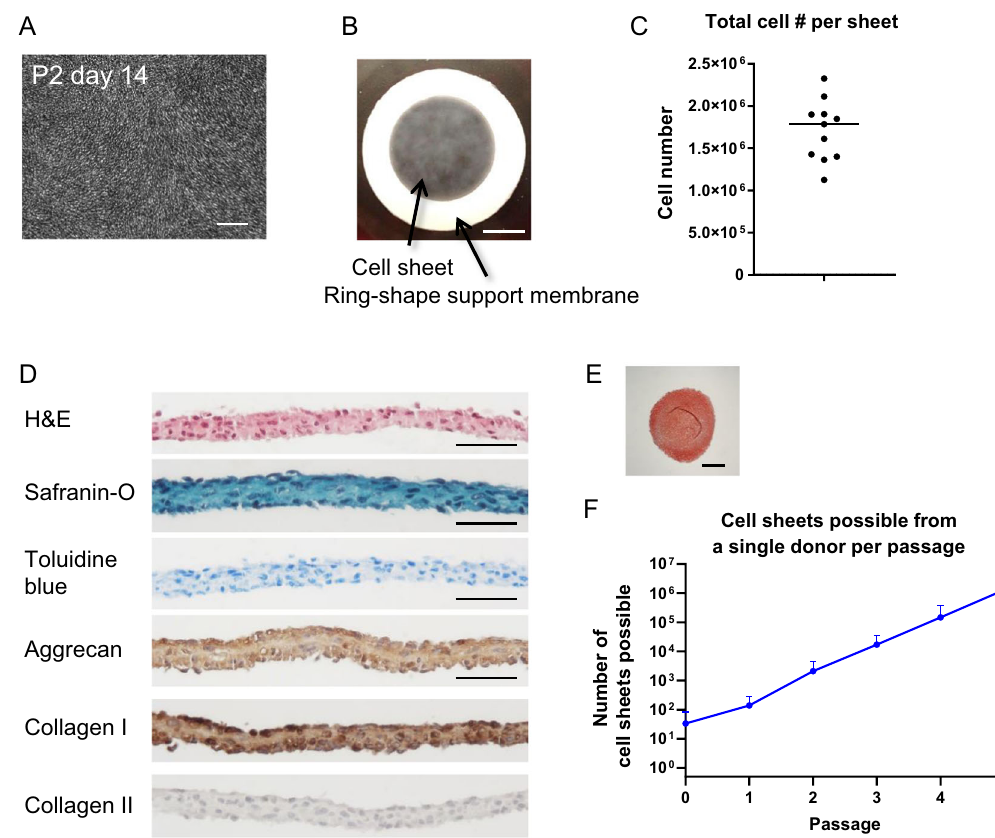
Fig. 2 Characterization of engineered JCC sheet. A A phase-contrast image of con fl uent chondrocytes at day 14 of passage 2. Scale bar: 200 µm. B Macroscopic image of engineered JCC sheet. Scale bar: 5 mm. C Total cell number in one cell sheet ( n = 13 individual donors). D Hematoxylin and eosin staining, Safranin-O staining, Toluidine blue staining, aggrecan, type I collagen, and type II collagen immunohistochemistry of JCC sheets. Bars: 50 µm. E Safranin-O staining of an in vitro differentiated pellet from P2 JCC sheet. Bar: 500 µm. F Theoretical cell sheet numbers possibly prepared from cultured JCCs at each passage. Data shown as mean and SD ( n = 11 individual